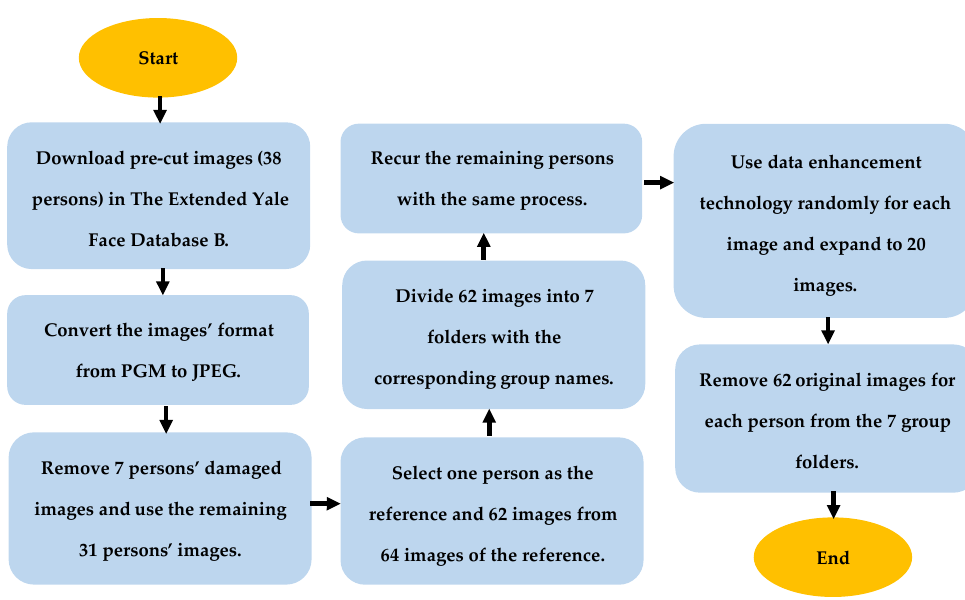
Figure 7. Data set processing flow chart.